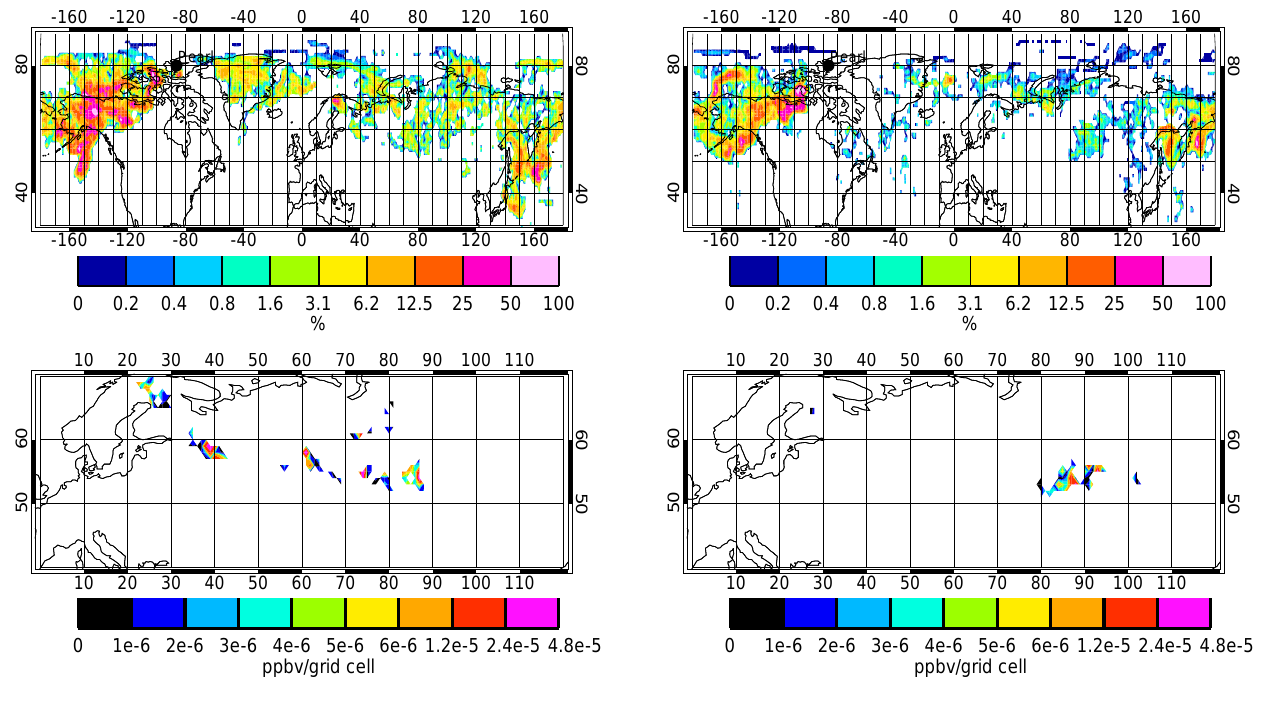
Fig. 11. Similar to Fig. 9, but for particles arriving at the recep- tor between 1 September 2006, 00:00UTC and 2 September 2006, 12:00UTC. Maximum residence time: 16.3s.